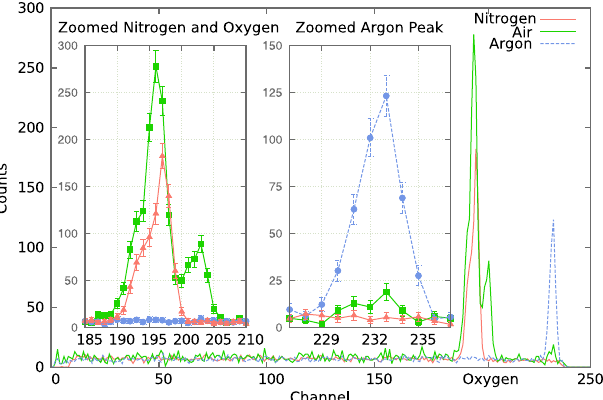
FIG. 8. The spectrum of scattered particles from a 1.8 MeV proton beam on the air supersonic gas jet. The surface barrier detector was set at a 165° angle. The regions of interest (for nitrogen, oxygen and argon) are shown in the center part of the plot along with the statistical error bars.